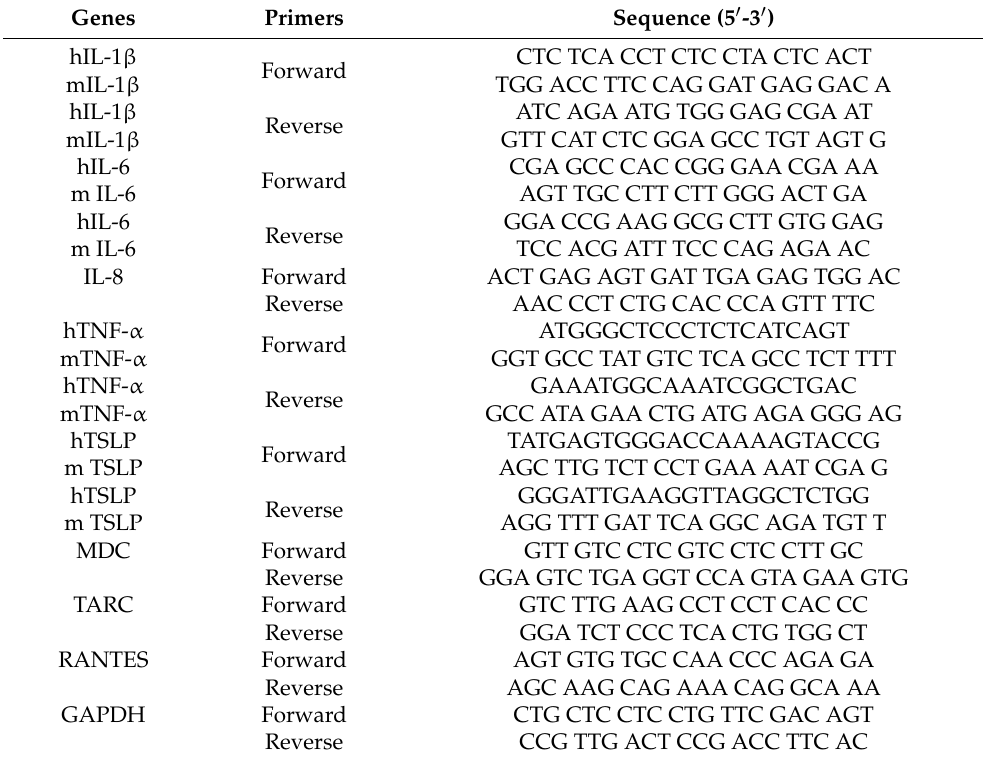
Table 1. Primer sequences for